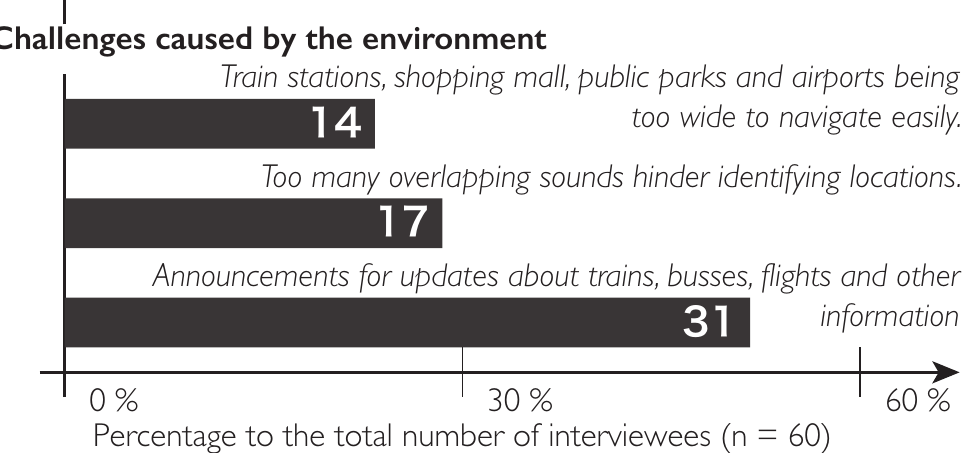
Figure 1. Basic challenges faced by visually impaired travelers. The participants were asked to express their views regarding the locations in which auditory cues should be installed. The participants’ views overwhelmingly exposed their hopes regarding the installation of auditory cues at different locations. The participants’ answers varied widely, reflecting differences between train users and those who use other modes of transportation, and these are mentioned in Table 4. As seen from this table, the train users pointed to a need to install auditory cues in railway station facilities, such as at the station entrance, and the need to distinguish between the upward- and downward- moving escalators. They also pointed to the need to install auditory cues for other facili- ties—such as to distinguish the male and female toilets and turnstiles, ticket offices, exits, and elevators. The importance of installing auditory cues at the areas mentioned above is also highlighted in Kurakata et al.